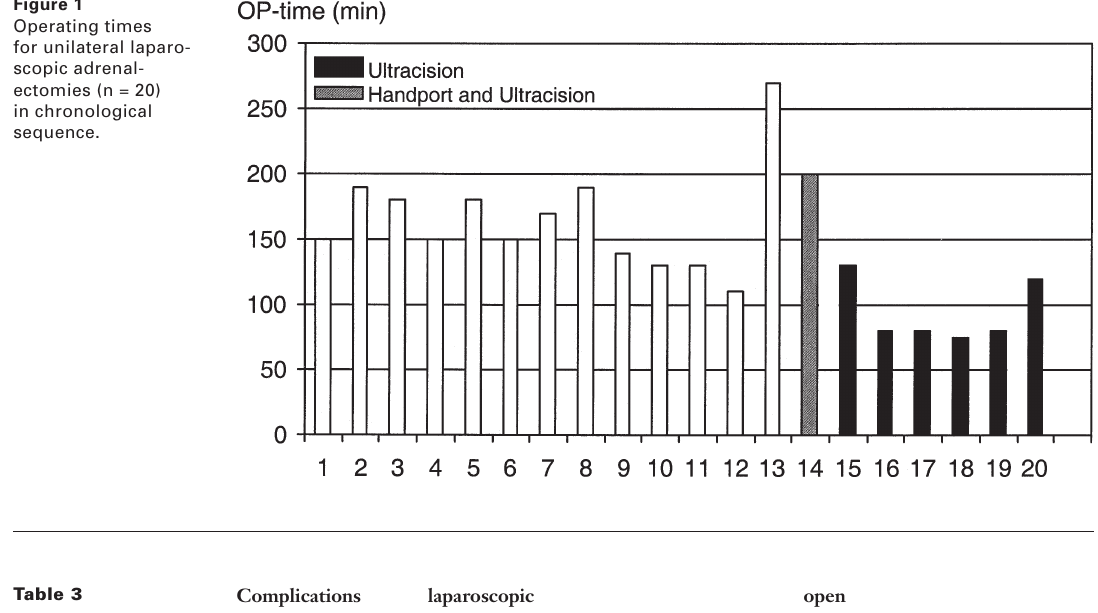
Figure 1 Operating times for unilateral laparo- scopic adrenal- ectomies (n = 20) in chronological sequence.